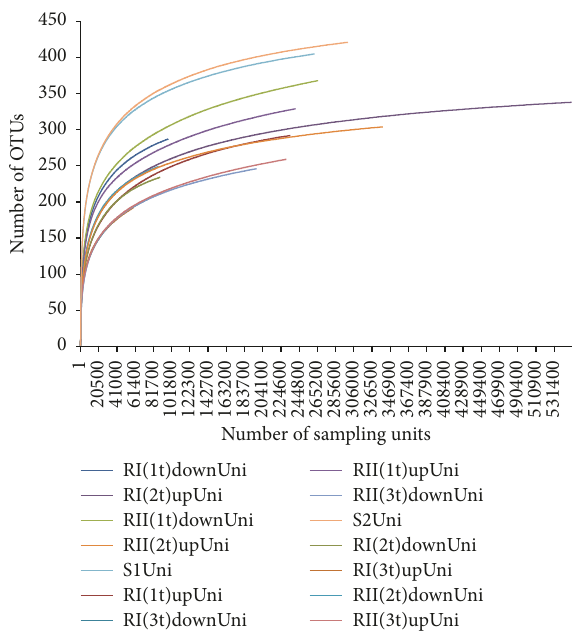
Figure 2: Rarefaction curve of the microbial diversity throughout the time course of anaerobic digestion of microalgae and sodium acetate.